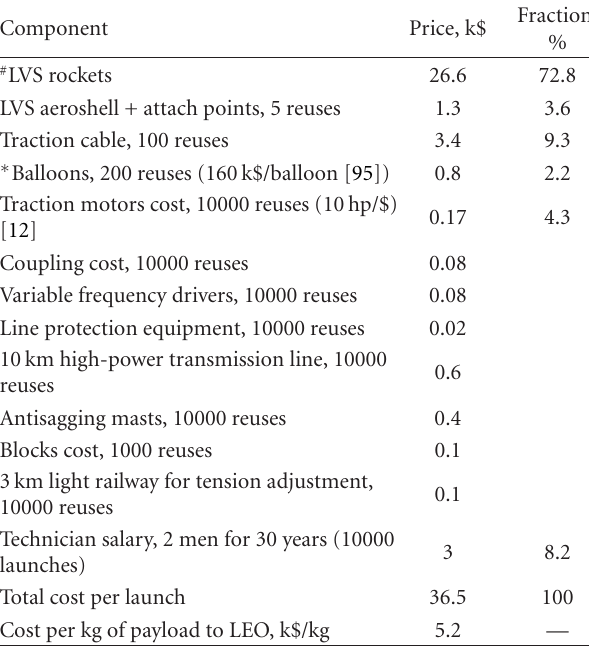
Table 2: Parameters of the proposed LAS.